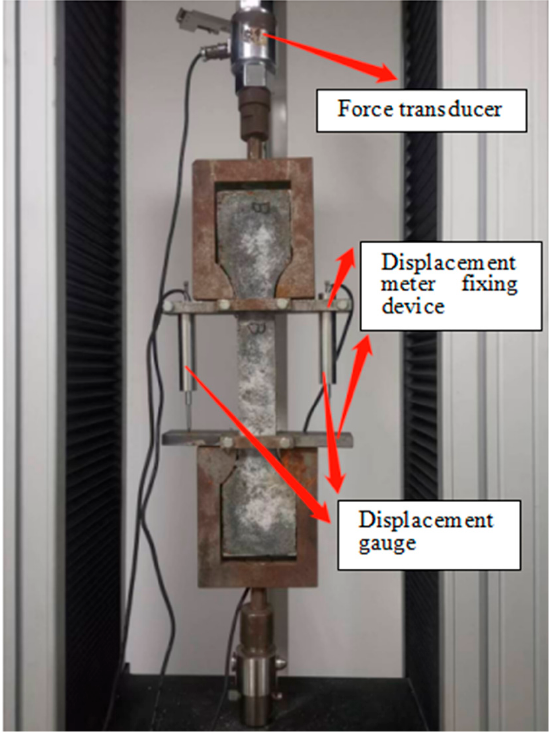
Figure 3. Loading diagram of uniaxial tensile specimen.